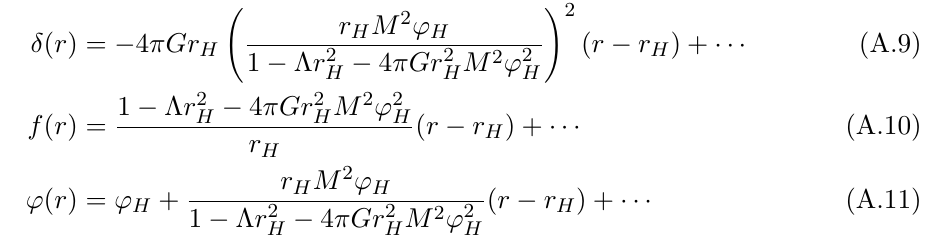
Figure 24 . Solutions f, ϕ, δ of Eulidean BH when r H is chosen so that J